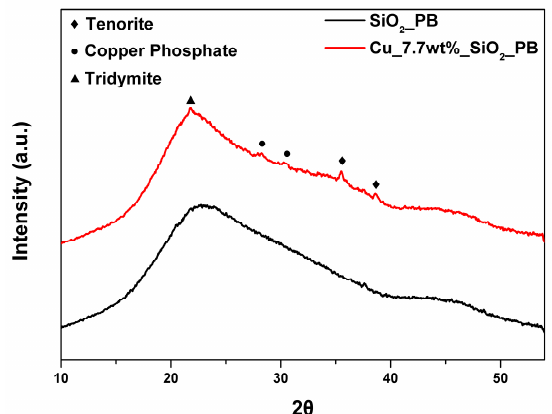
Figure 1. X-ray diffraction (XRD) patterns of samples produced with phosphate buffer. Figure 1. X ‐ ray diffraction (XRD) patterns of samples produced with phosphate buffer.